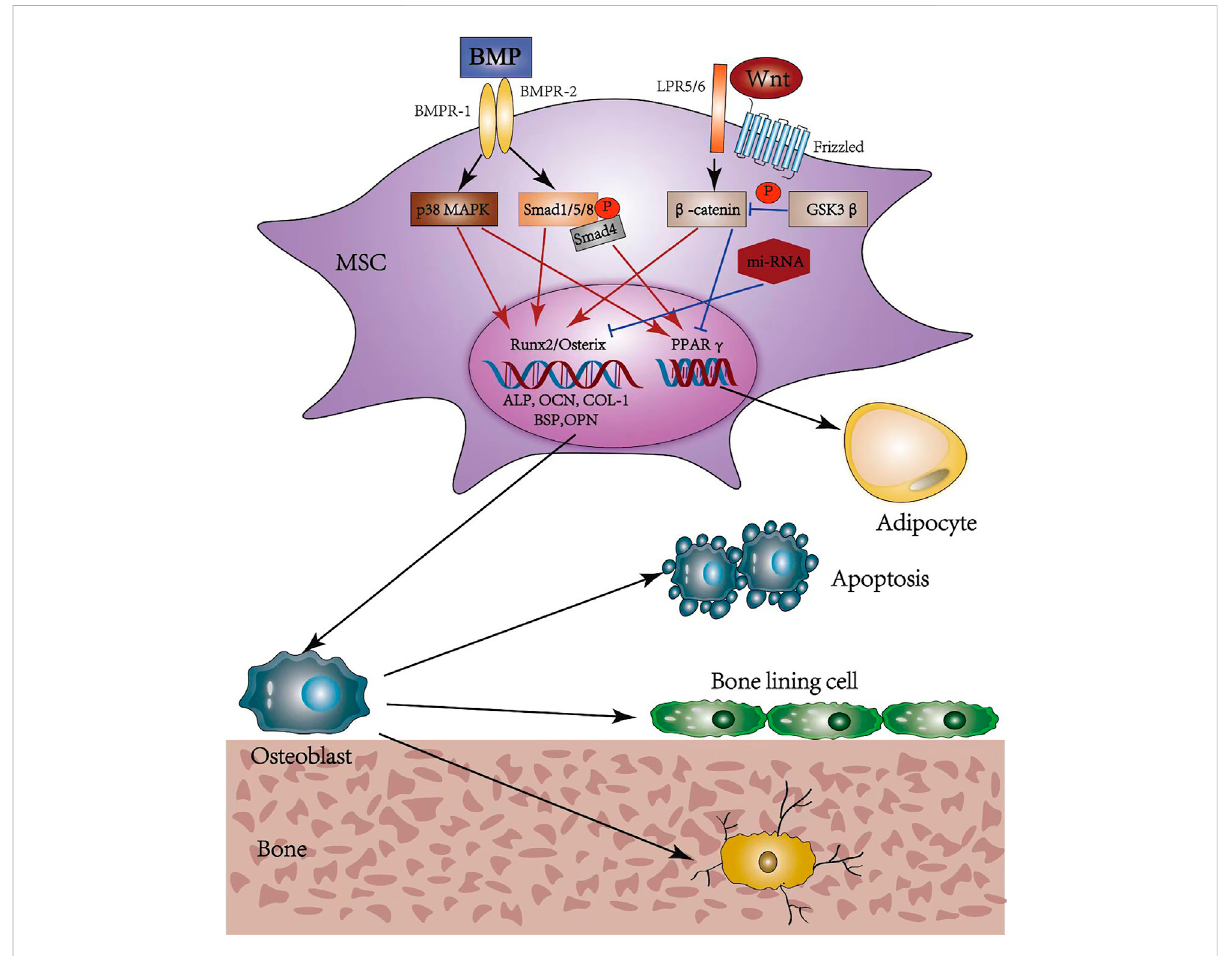
FIGURE 4 Osteogenic differentiation pathways and possible fates of osteoblasts. MSC, mesenchymal stem cell; BMP, bone morphogenic protein; BMPR, bonemorphogenicproteinreceptor;MAPK,mitogen-activatedproteinkinase;Smad,smallmothersagainstdecapentaplegic;Wnt,winglessandint- 1; LRP, low density lipoprotein receptor-related protein; GSK, glycogen synthase kinase; Runx2, runt-related transcription factor 2; ALP, alkaline phosphatase; OCN, osteocalcin; COL-1, collagen-1; BSP, bone sialoprotein; OPN, osteopontin; PPAR γ , peroxisome proliferation-activated receptor γ